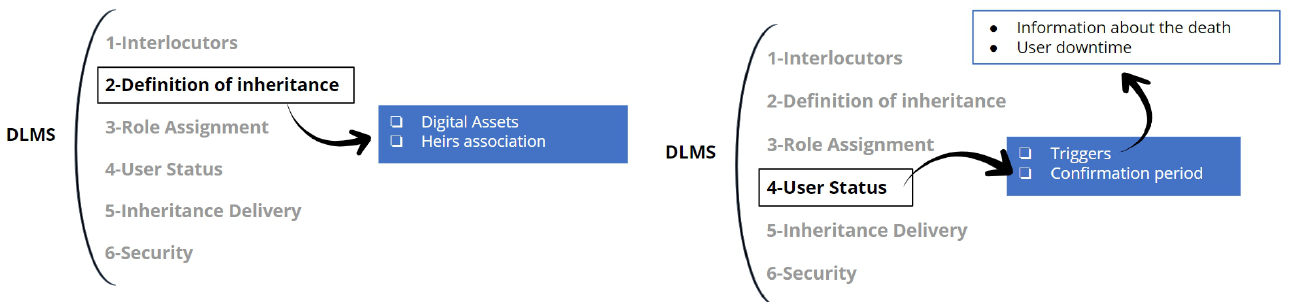
Fig. 3. Definition of Inheritance in DiLeMa Framework.